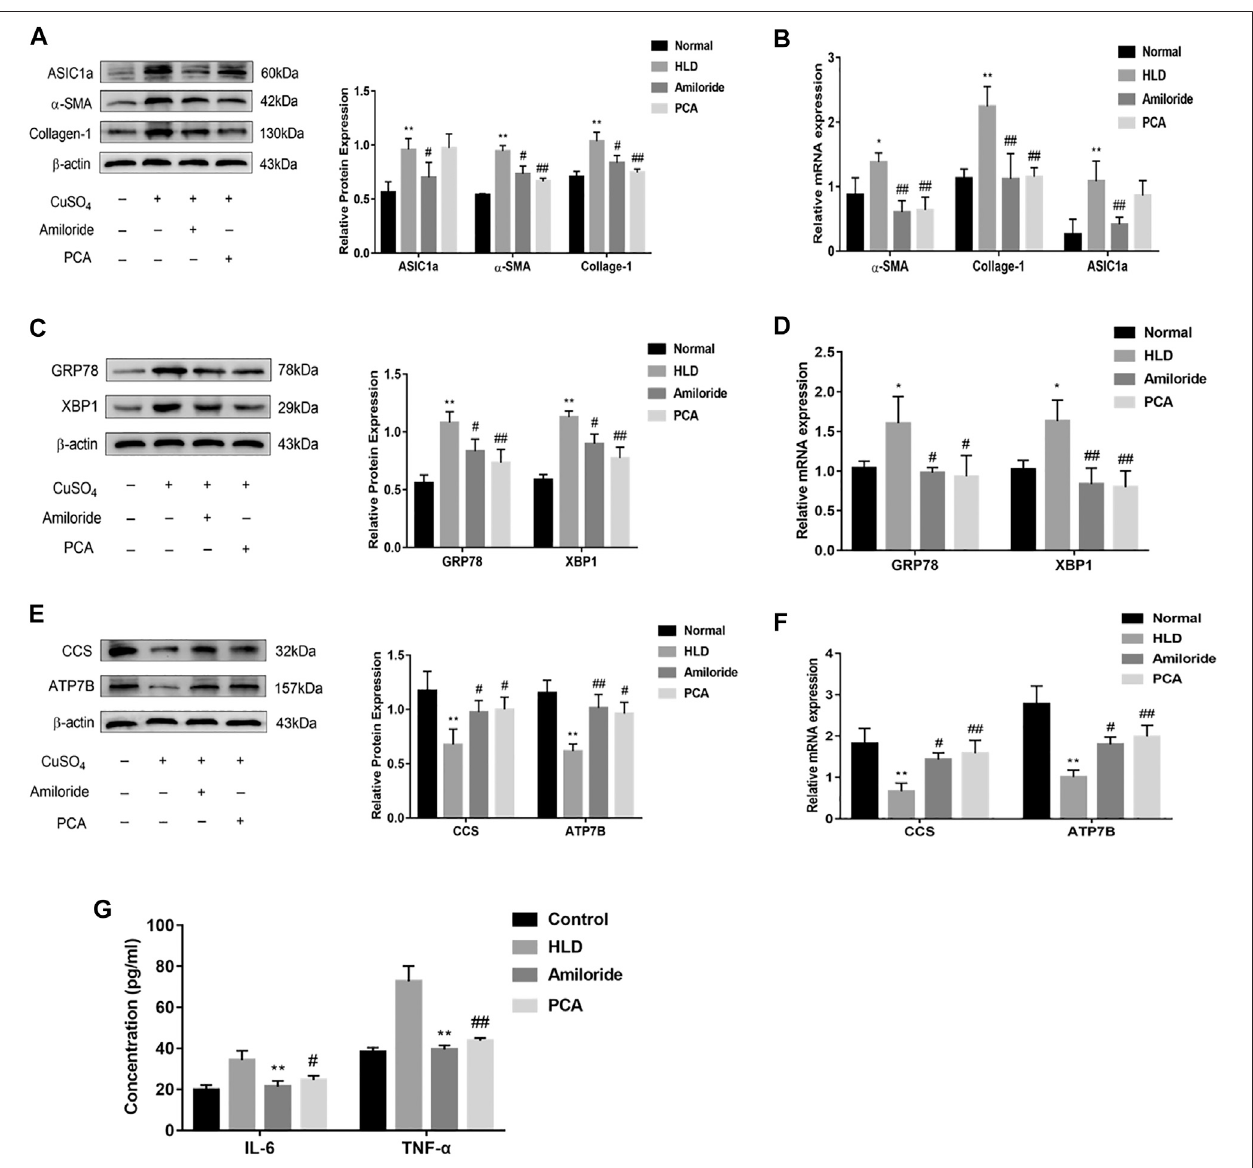
FIGURE 8 | Protein and mRNA expression in liver tissues of Wistar rats treated with copper. Western blotting analysis and densitometric quanti fi cation of ASIC1a, α -SMA, and Collagen-I (A) , ERS marker protein GRP78, XBP1 (C) , ATP7B, and CCS (E) in the Wistar rats in each group. Changes in the gene expression of ASIC1a, α -SMA, and Collagen-I (B) , the ERS marker protein GRP78, XBP1 (D) , ATP7B, and CCS (F) in the liver tissues of copper-treated rats after amiloride and penicillamine treatment (G) Serum levels of IL-6 and TNF-a in Wistar rats. Statistical analyses were performed using a t -test. The data are expressed as the mean ± SEM ( n (cid:2) 4). * p < 0.05, ** p < 0.01 vs. Normal group; # p < 0.05, ## p < 0.01 vs. HLD